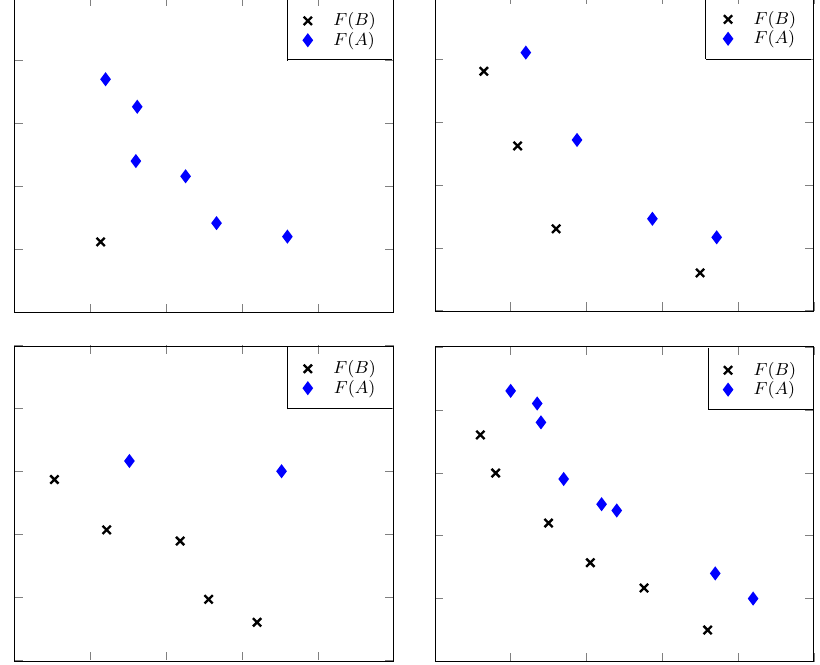
Figure 3. Different scenarios where the GD p value of archive B is better (smaller) than the GD p value of archive A independently of the Pareto set and where the additional assumptions made in Theorem 5 are easily